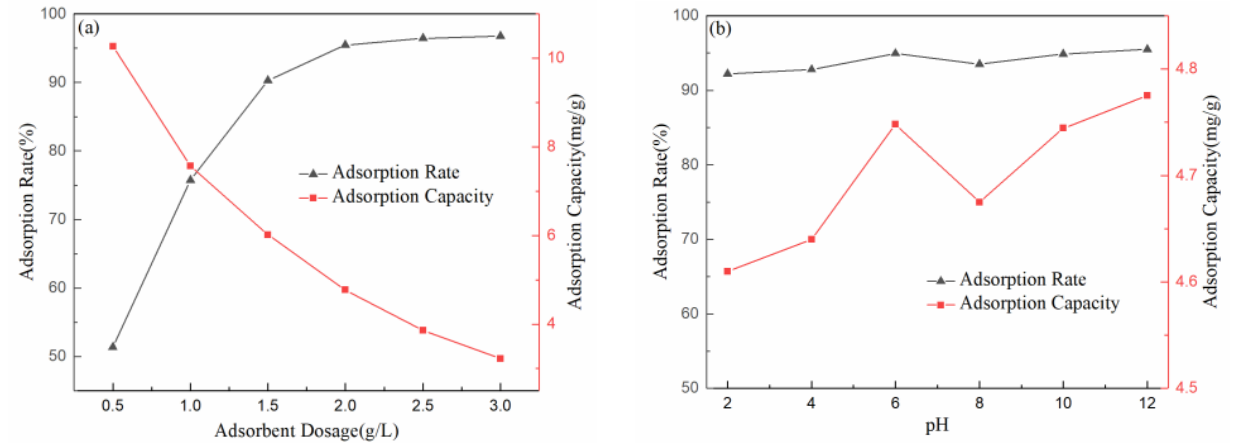
Figure 5. Effect of different dosages of adsorbent and pH change on Sb (III) adsorption. ( a ). Effect of different doses of adsorbents on the adsorption of Sb (III); ( b ). Effect of pH on the adsorption of Sb (III) by adsorbents.